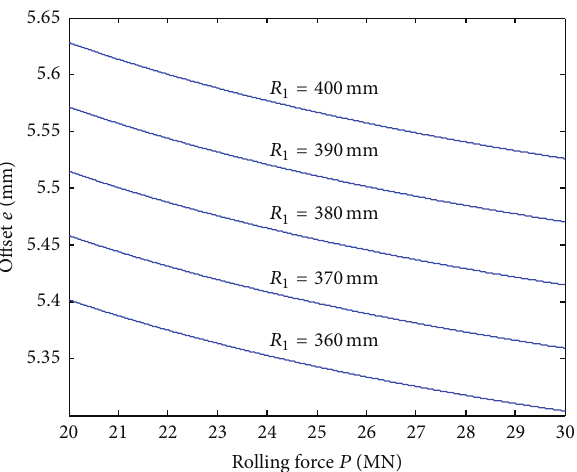
Figure 2: Minimum offset calculation.